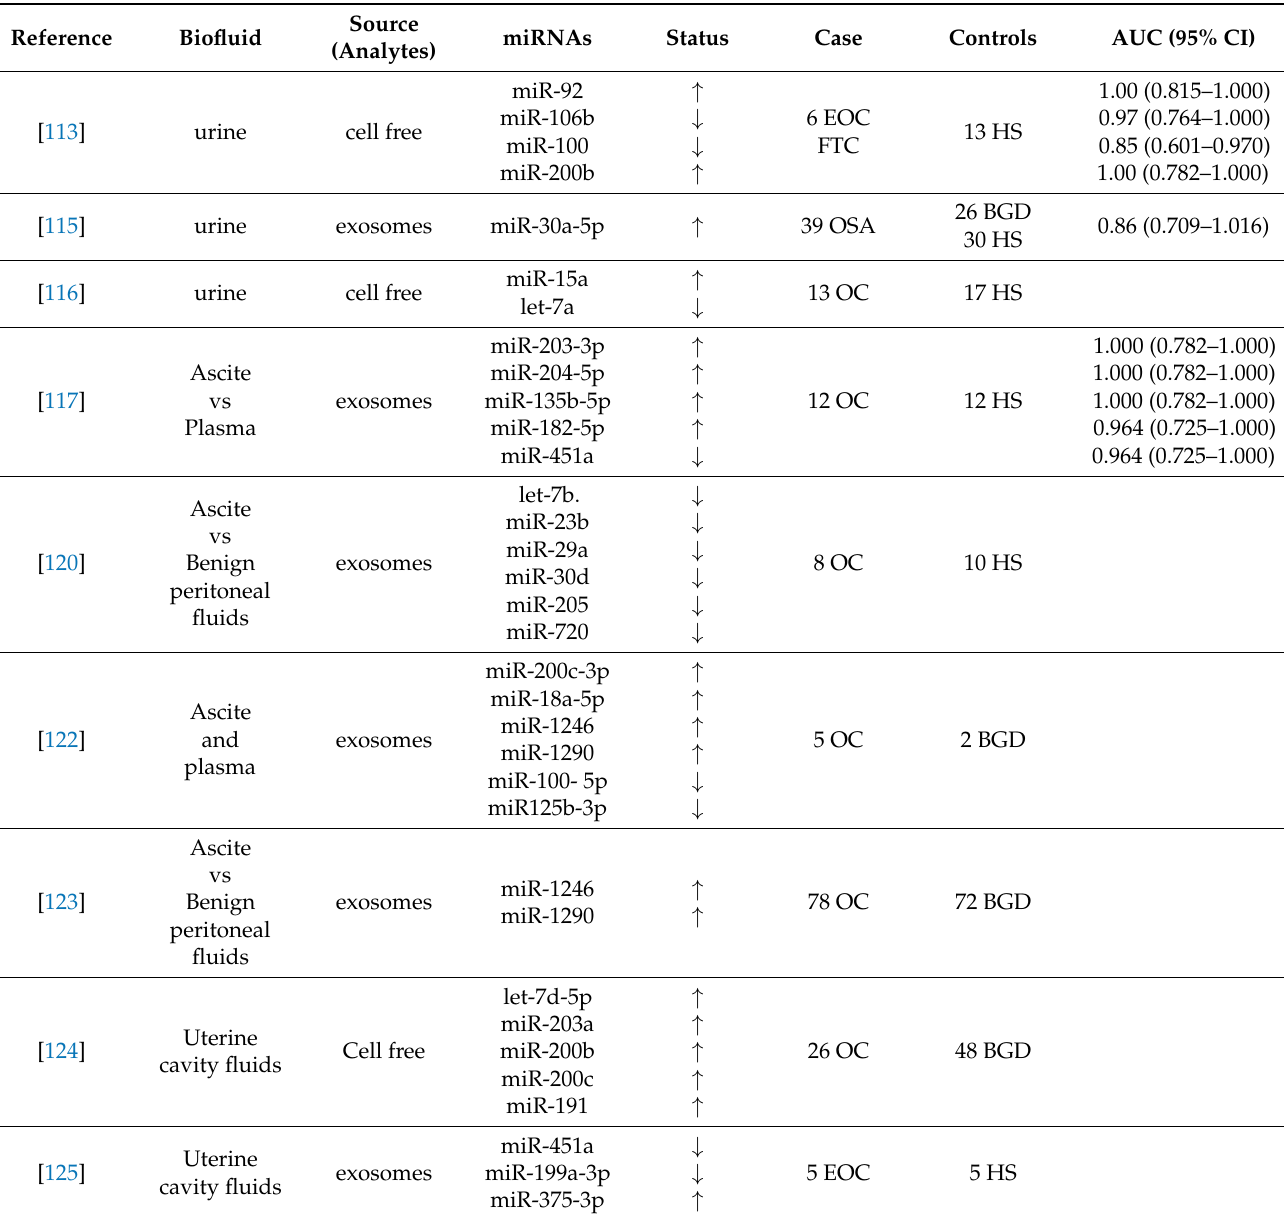
Table 2. Biofluids other than blood or saliva for OC liquid biopsy and miRNAs BMs search (as selected by this review’s authors). EOC: FTC: fallopian tube cancer; HS: healthy subject; BGD: benign gynecological disease; AUC: area under the ROC curve. Each row provides information regarding the citation in parenthesis at the far left end of the